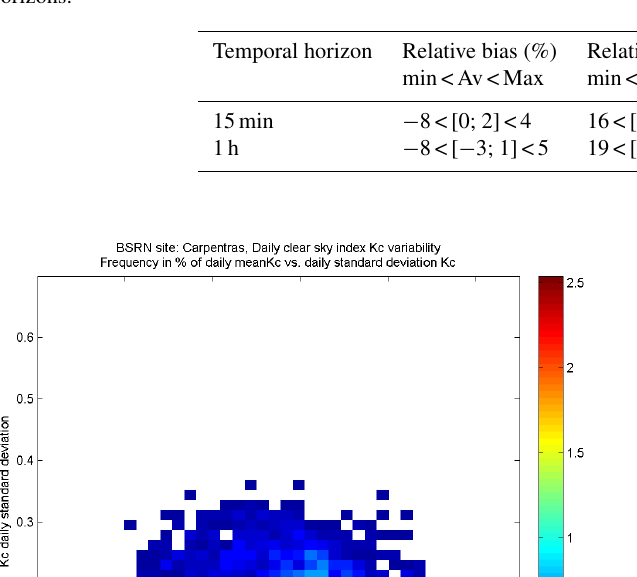
Table 2. Most probable ranges and extremes of the validation results of the forecasts of the 15min irradiation for the 15min and 1h temporal horizons.